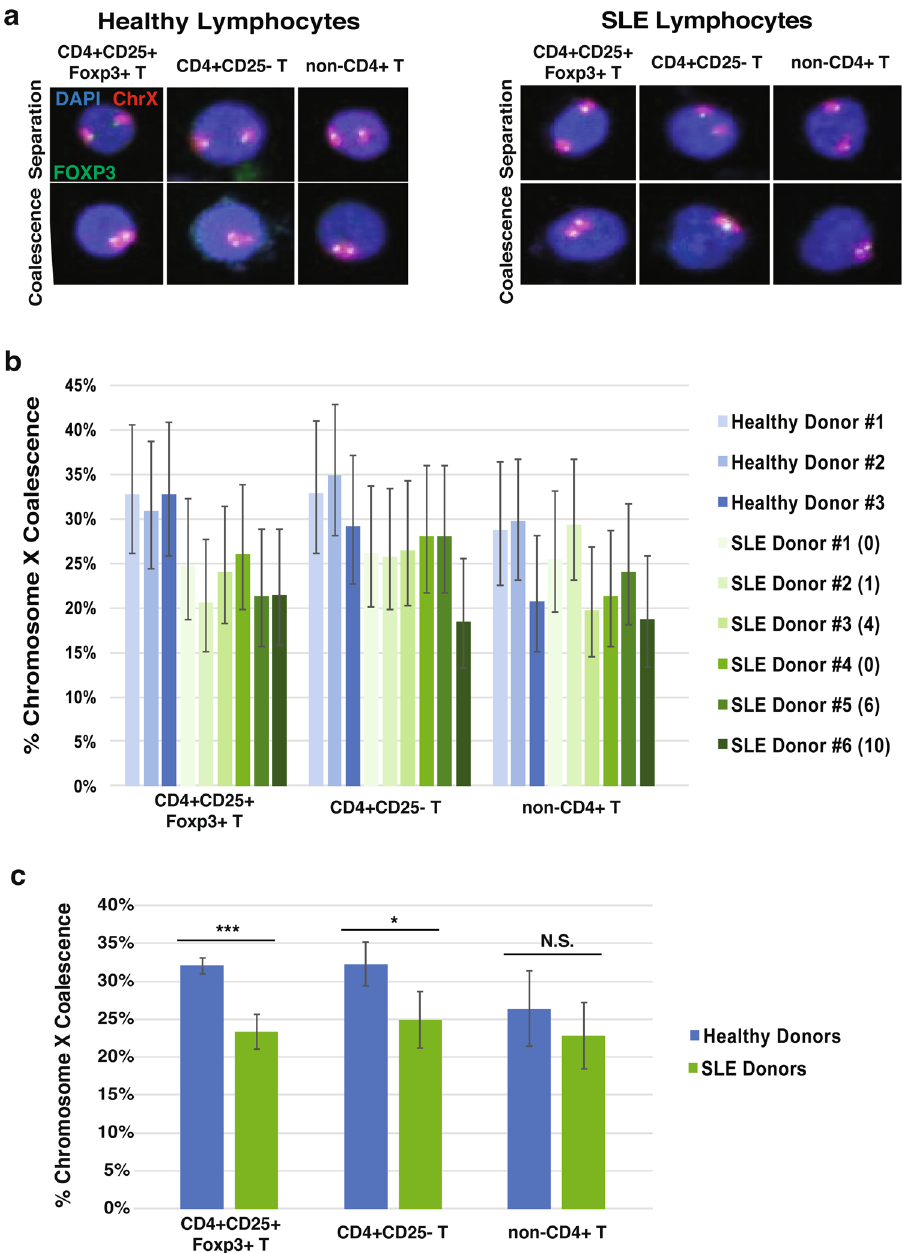
Figure 6. Human female systemic lupus erythematosus (SLE) CD4 + T lymphocytes exhibit significant differences in chromosome X organization compared to healthy controls. ( a ) 3D maximum intensity projections of human female healthy (left panels) and SLE (right panels) lymphocyte nuclei (blue) with FOXP3 (green) and chromosome X (red) labeled during X separation (top panels) and coalescence (bottom panels). ( b ) 3D chromosome X coalescence frequency of healthy and SLE regulatory T cells (CD4 + CD25 + Foxp3 + ), CD4 + CD25- T cells, and non-CD4 + T cells. Each column represents approximately 150 nuclei analyzed, error bars designate 95% confidence intervals. SLEDAI-2 donor score given in parenthesis. ( c ) Chromosome X coalescence frequency of healthy and SLE regulatory T cells (CD4 + CD25 + Foxp3 + ), CD4 + CD25- T cells, and non-CD4 + T cells. Values presented as mean ± standard deviation. * P < 0.05, ** P < 0.01, *** P < 0.001, NS. = Not Significant, Student’s t -test. Each column represents approximately 450 healthy or 900 SLE nuclei